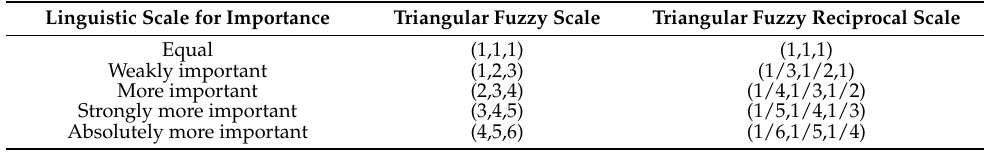
Table 1. Basic linguistics and